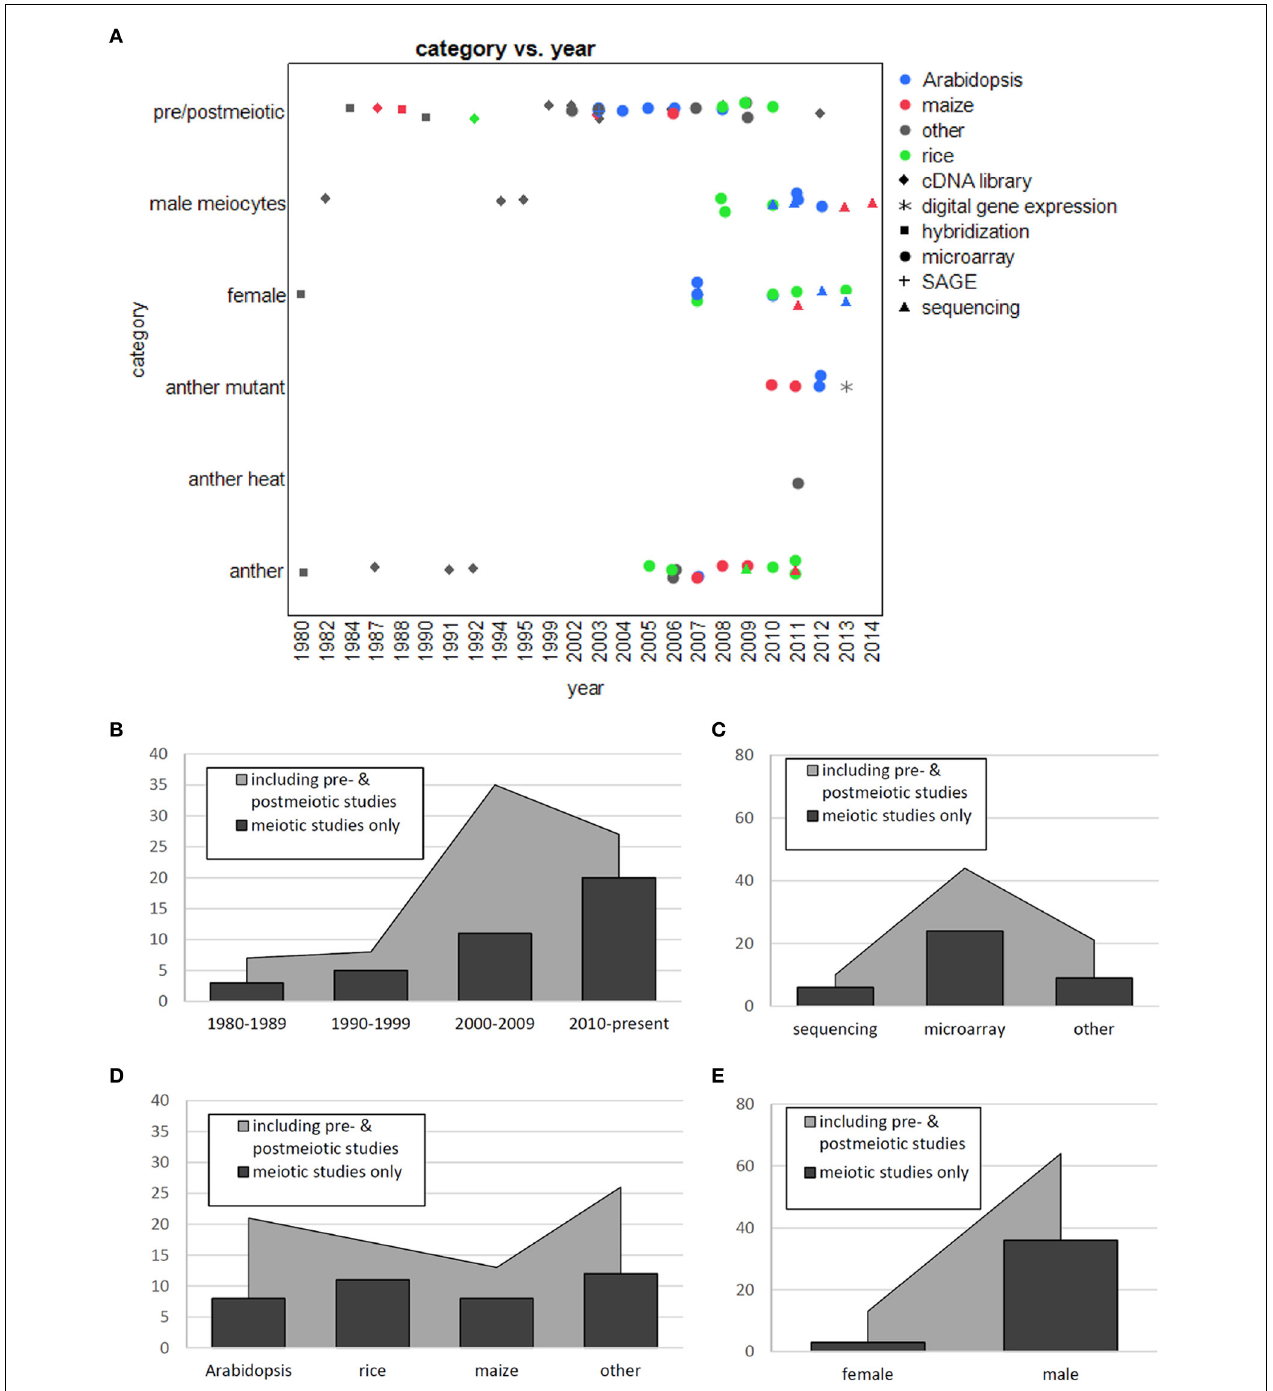
FIGURE 2 | Distributionofprimaryliteratureontranscriptomesofreproductivestructures.(A) Scatterplotwithspeciescodedbycolor,techniquesbyshape. (B) Transcriptome studies per decade. (C) Transcriptome studies per technology. (D) Transcriptome studies per species. (E ) Transcriptome studies per gender.